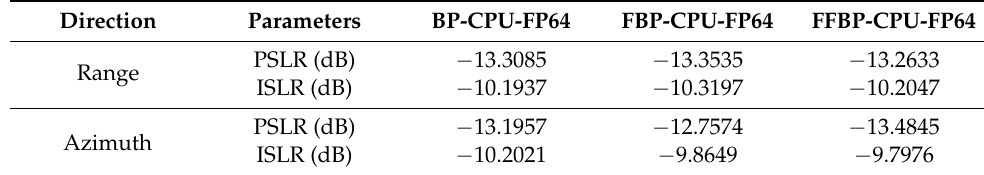
Table 3. Imaging indicators of the CPU schemes.